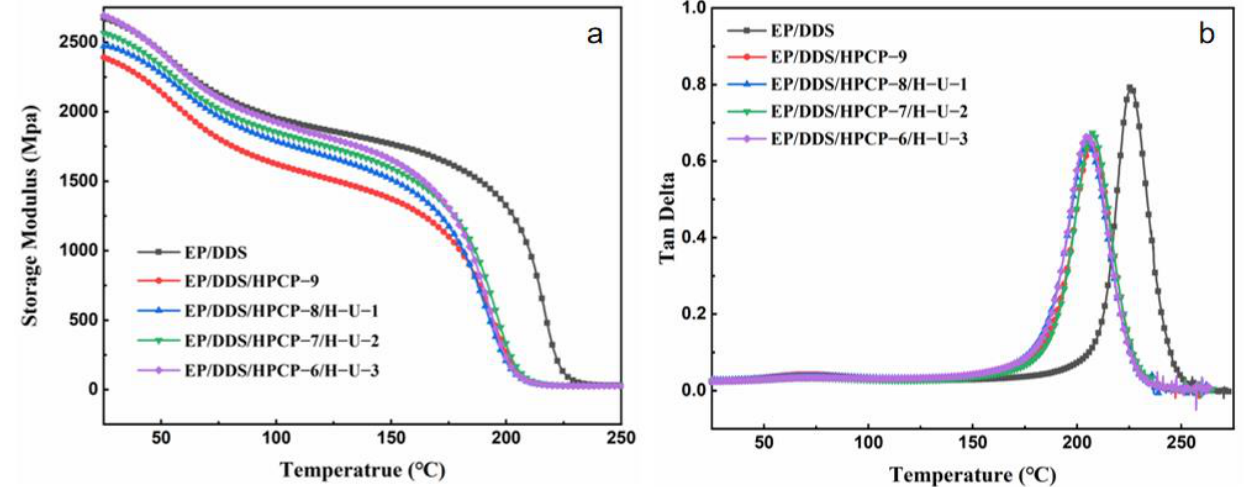
Figure 6. Storage modulus ( a ) and tan delta ( b ) curves of EP samples vs. temperature.